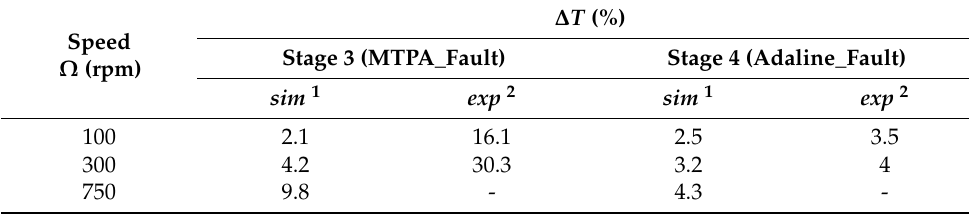
Figure 5. (Numerical result) The torque at 100 rpm (green), 300 rpm (blue), and 750 (red) rpm in the four operating stages, and 23 Adaline weights at 750 rpm with learning rate η = 0.0003 in stage 4. Table 4. Comparisons between stages 3 (MTPA_Fault) and 4 (Adaline_Fault) in terms of torque ripples at different speeds when phase A is opened.